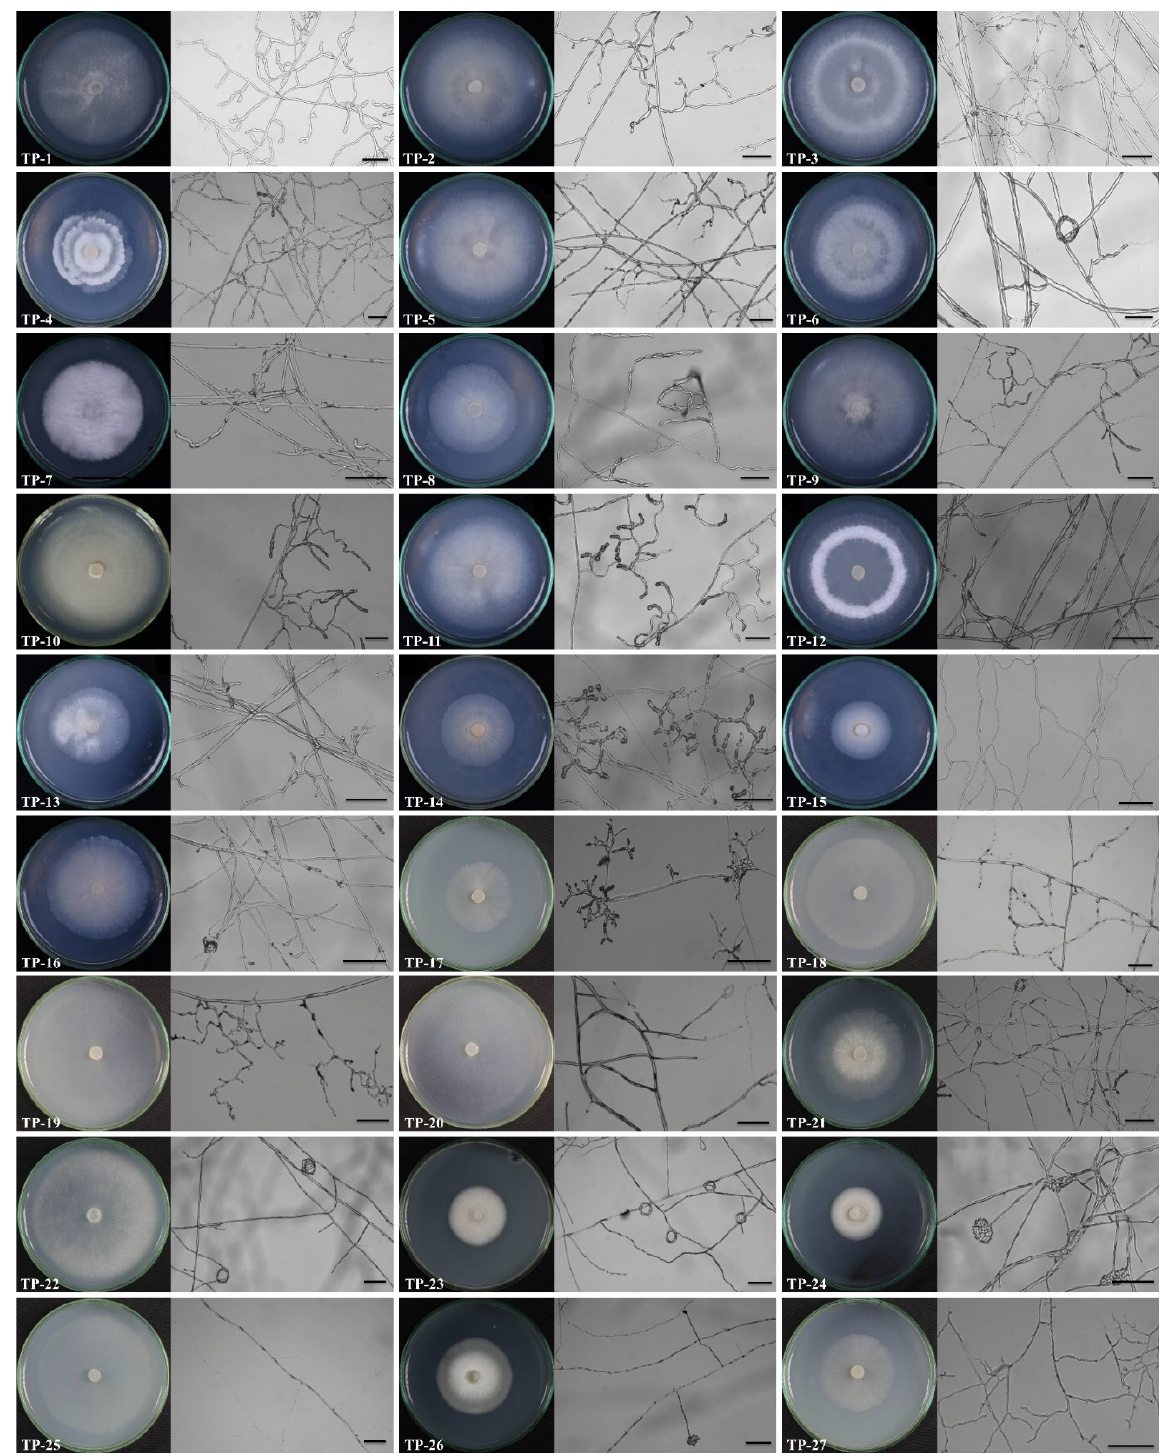
Figure 2. The colonies and in vitro morphological characteristics of hyphae for 27 fungi obtained